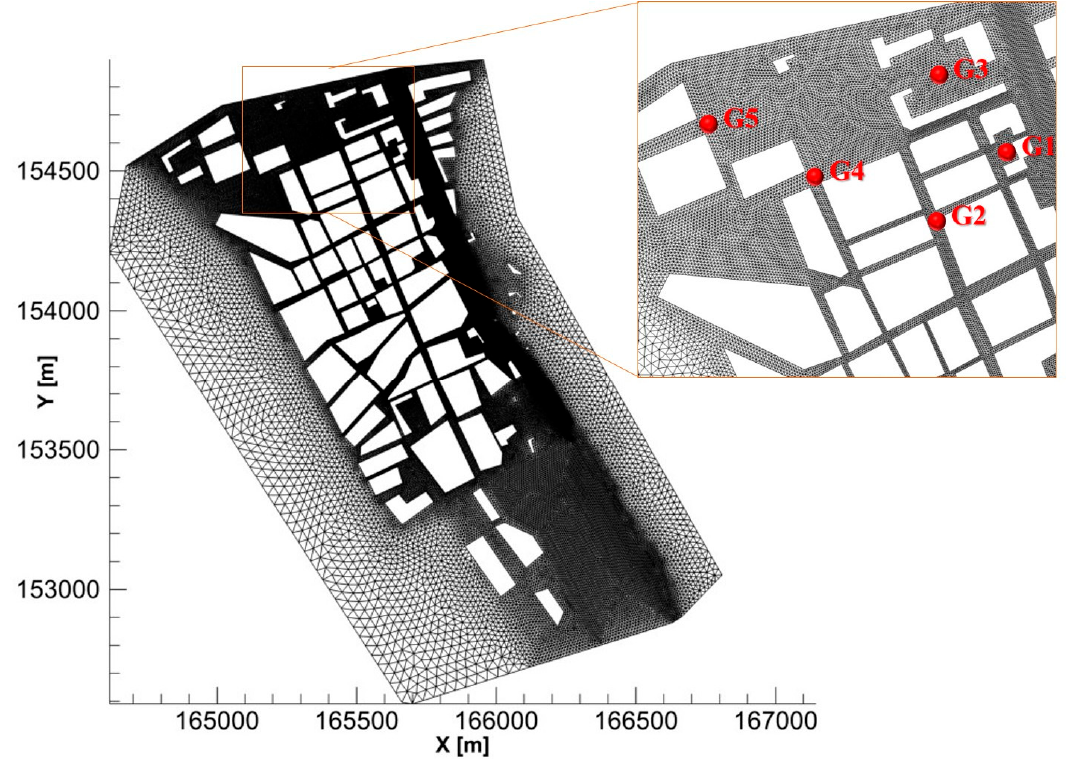
Figure 5. Unstructured grid system and locations of the five check points.